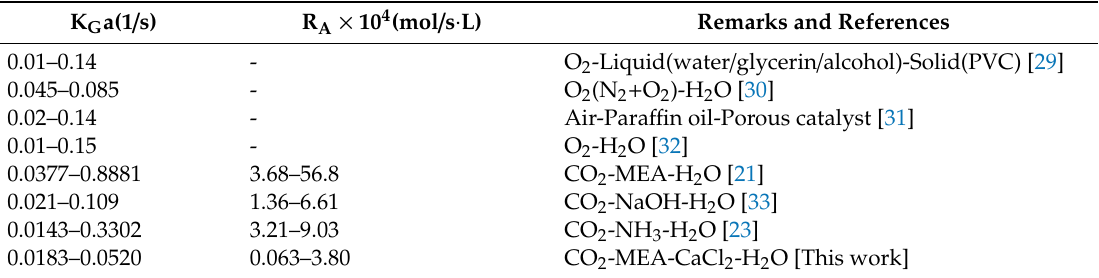
Figure 10. A plot of calculated K G a versus measured K G a. Table 3. Comparison of mass-transfer coefficients in the bubble columns.